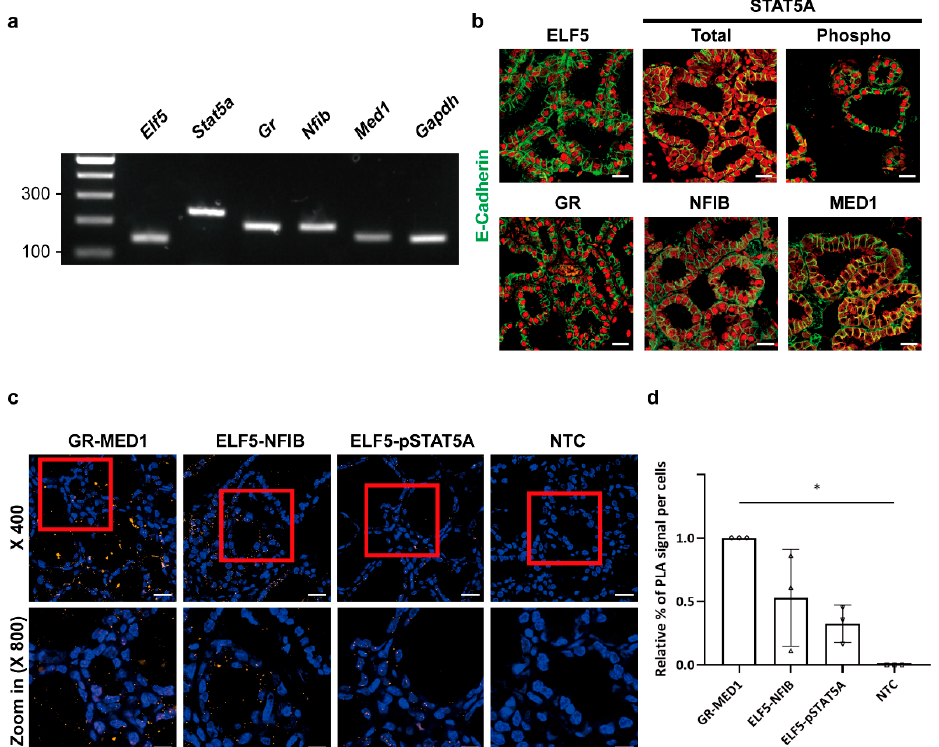
Figure 3. In situ protein–protein interactions of mammary-enriched transcription factors detected by PLA in lactating mouse mammary epithelium. ( a ) Endogenous expression levels of Elf5 , Stat5a , Gr , Nfib , Med1 , and Gapdh genes in mouse mammary tissue obtained at L1. mRNA levels of each gene were measured by RT-qPCR. ( b ) Immunofluorescence of ELF5, STAT5A, GR, NFIB, and MED1 proteins in mouse mammary tissue obtained at L1 (400 × ). Each transcription factor is stained in red, and the epithelial marker E-cadherin is stained in green. pSTAT5A was detected using an anti- phospho-STAT5 antibody. Representative images from three independent experiments are shown. Scale bars, 20 µ M. ( c ) PLA signals in mouse mammary tissue at L1 visualized at low magnification (400 × ; scale bar, 20 µ M) and high magnification (800 × ; scale bar, 10 µ M). PLA signals are shown in orange, and DAPI-stained cell nuclei are shown in blue. The GR and MED1 pair was used as a positive control. Representative images from three independent replicates are shown. ( d ) Relative percentage of PLA signals per cell. The number of PLA puncta in DAPI-stained nuclei was counted from five different fields in each slide from three different donor mice (* p < 0.05). NTC, non-treated control. A circle, GR-MED1; a triangle, ELF5-NFIB; an inverted triangle, ELF5-pSTAT5A; a square,